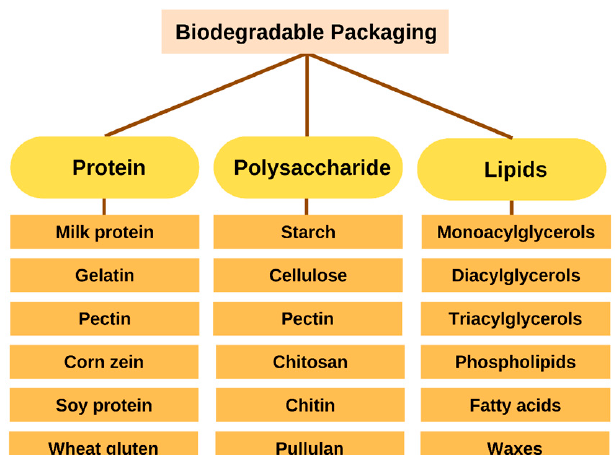
Figure 2. Classification of biodegradable packaging.